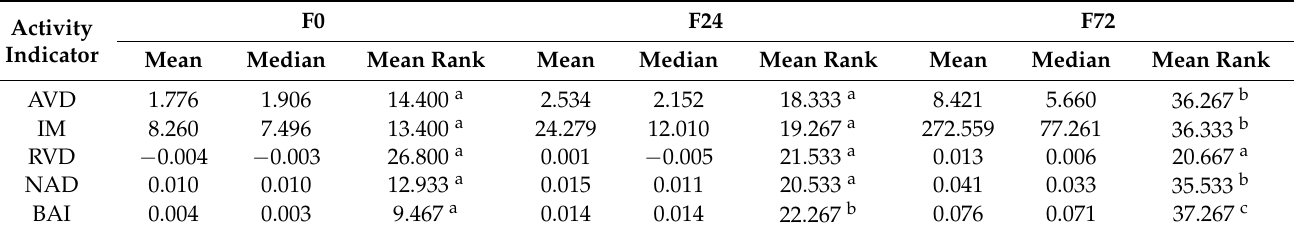
Table 3. Basic statistics for biospeckle indices calculated for THSP obtained from a random set of points follow a Gaussian